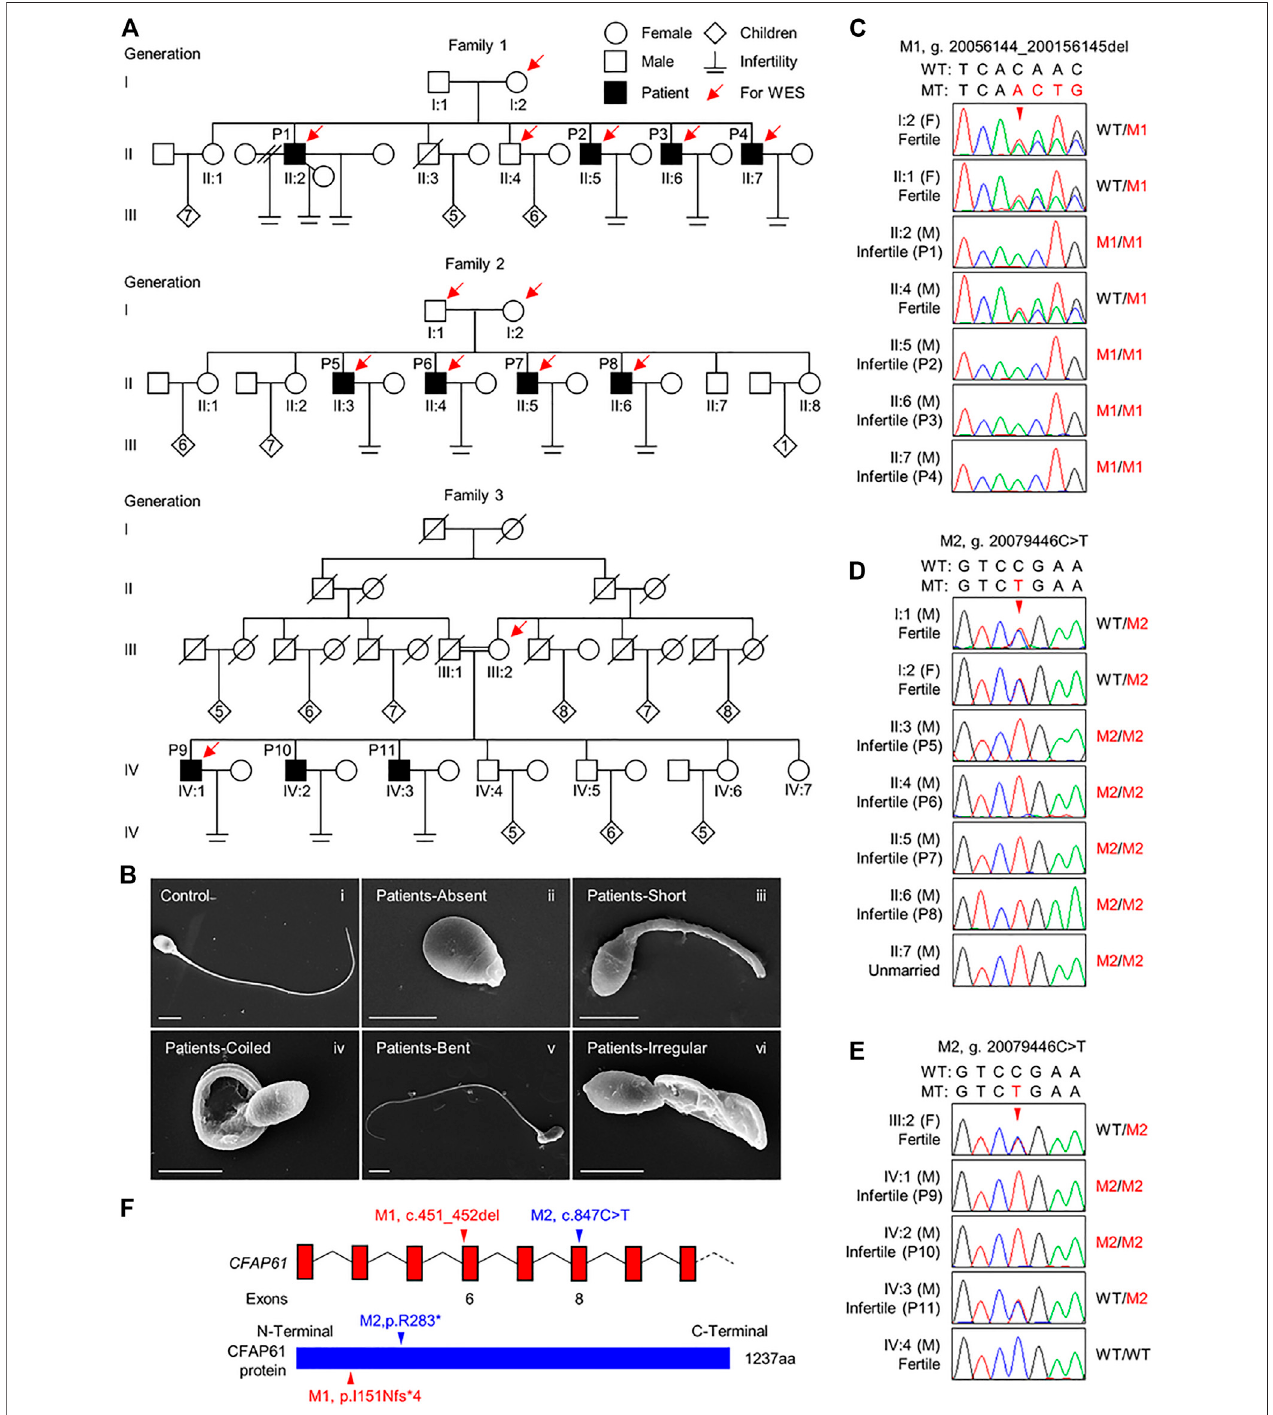
FIGURE 1 | CFAP61 variants identi fi ed in three Pakistani families with MMAF. (A) Pedigreesof family 1 with four infertile patients, P1 (II:2), P2(II:5), P3 (II:6), and P4 (II:7),family2withfourinfertilepatients,P5(II:3),P6(II:4),P7(II:5),andP8(II:6)andfamily3withthreeinfertilepatients,P9(IV:1),P10(IV:2),andP11(IV:3).Arrowspointto the individuals for which whole-exomesequencingwas performed.Slashes denote deceased family members, doubleslash means divorce, and doublehorizontallines represent consanguineousmarriage. (B) Representative SEM micrographs showing sperm morphological abnormalitiesobserved in patients, including absent (ii), short(iii),coiled(iv),bent(v) fl agella,and fl agellaofirregularcaliber(vi).Arepresentativespermatozoonwithnormalmorphologyfromthefertilecontrolwasshown(i).Scale bars represent 4 μ m. (C – E) Veri fi cation of the CFAP61 variants, p. I151Nfs*13 (NC_000020.10:g. 20056144-200156145del) in family 1 (C) and p. R283* (NC_000020.10:g. 20079446C > T) in family 2 (D) and family 3 (E) by Sanger sequencing using genomic DNA from all the available family members. Arrowheads, the mutation sites. F, female; M, male. WT, wild-type allele. MT, the mutant allele. M1, c.451_452del. M2, c.847C > T. (F) The positions of the two variants in CFAP61 at transcript level (NM_015585.4) and protein level (NP_056400.3).